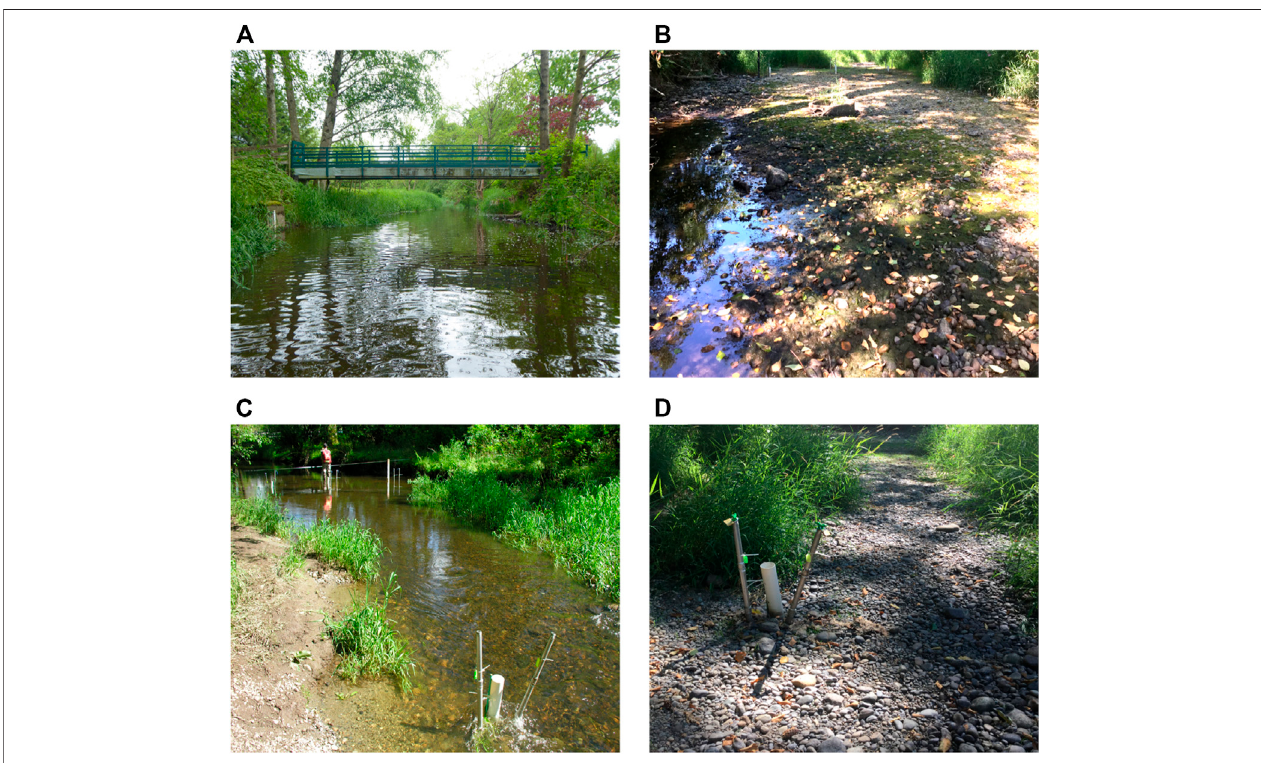
FIGURE 2 | (A) Pool habitat in the upstream segment of the Otter Park reach in May 2018 and (B) August 2018. (C) Rif fl e habitat in the upstream segment of the Otter Park reach in May 2018 and (D) August 2018.